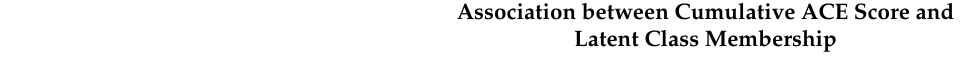
Table 5. Association between ACE Score & Victim Class